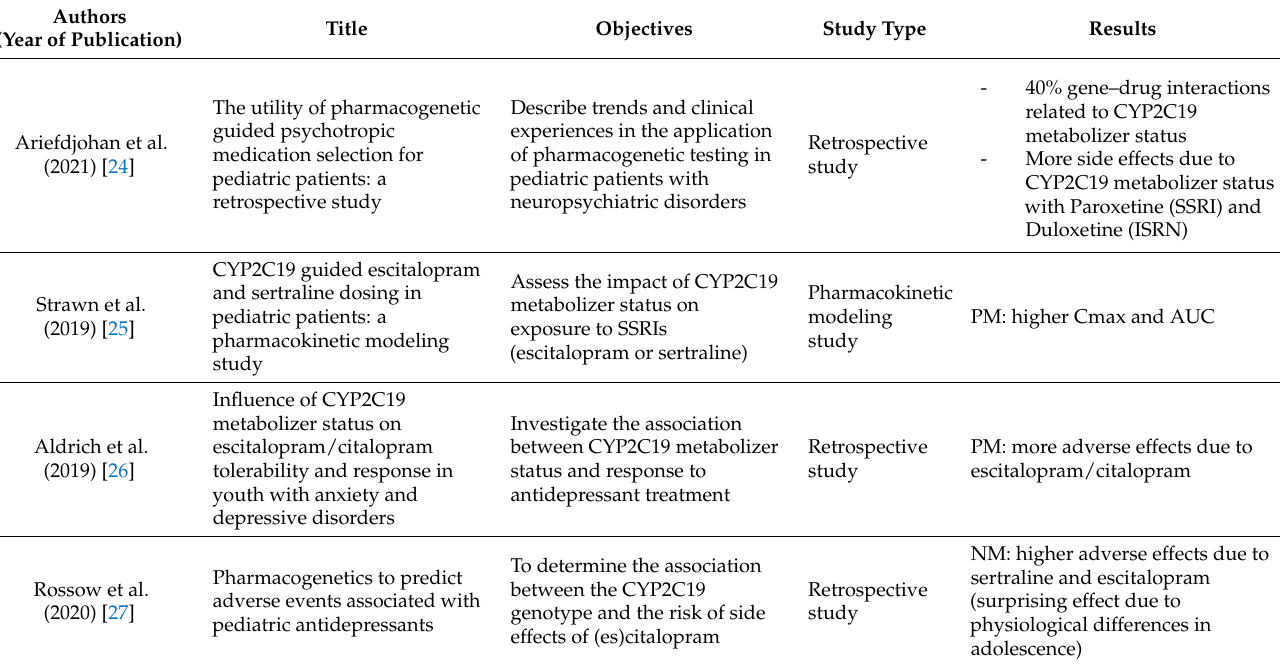
Table 4. Summary of studies on the influence of the CYP2C19 genotype on